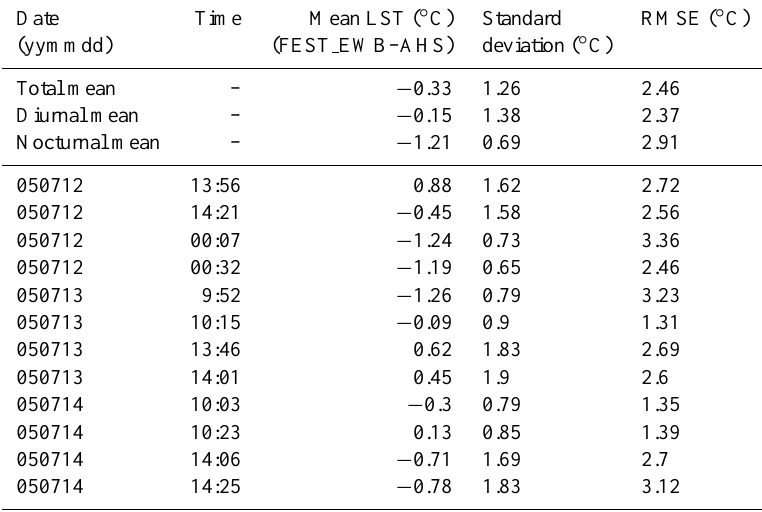
Table 3. Mean difference, standard deviation and RMSE between LST-AHS and FEST-EWB.